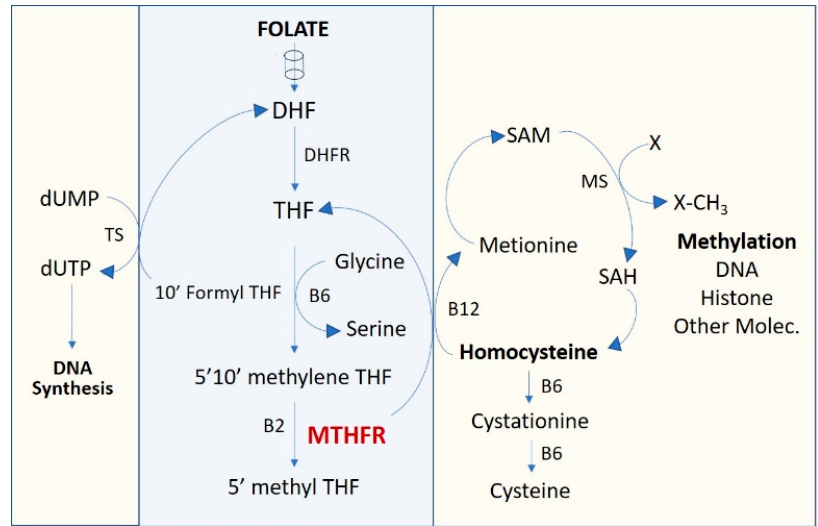
Figure 1. One-carbon metabolism pathway. DHF, dihydrofolate; DHFR, dihydrofolate reductase; dTMP, deoxythymidine monophosphate; dUMP, deoxyuridine monophosphate; MTHFR, methylenetetrahydrofolate reductase; SAM, S-Adenosyl methionine; THF, tetrahydrofolate.